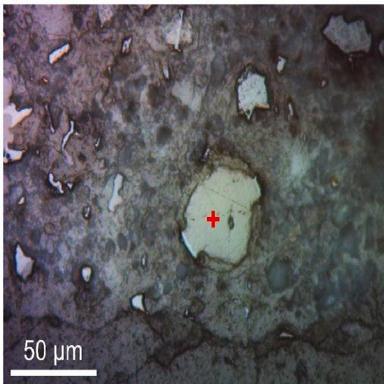
Raman spectra of (a) C4AF and (c) β-C2S identified in cracks (red cross) shown in optical micrographs (b and d) from samples with 0% CA and 1% CA,